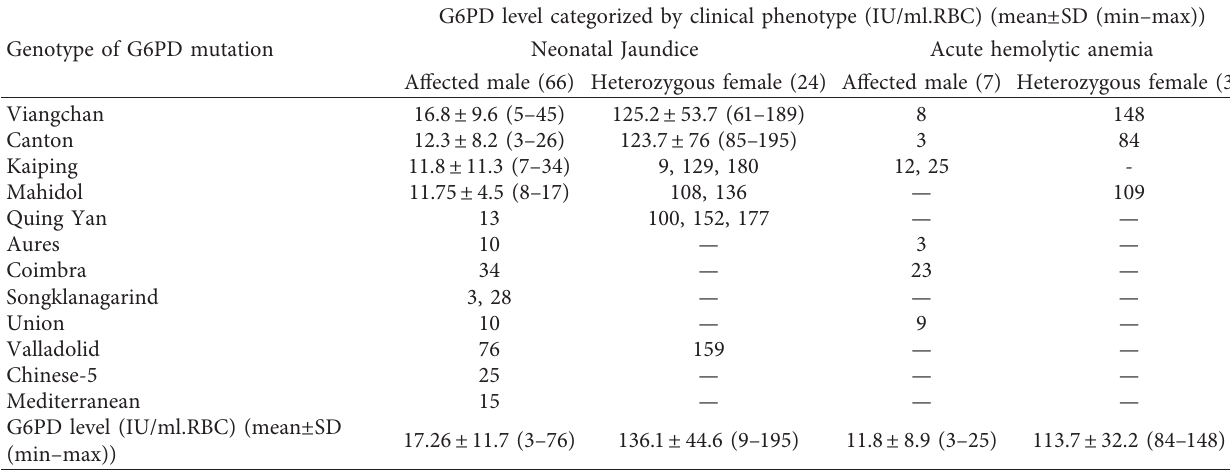
Table 4: G6PD levels categorized by the genotype of G6PD mutations and clinical phenotypes of 73 affected males and 27 heterozygous females. Genotype of G6PD